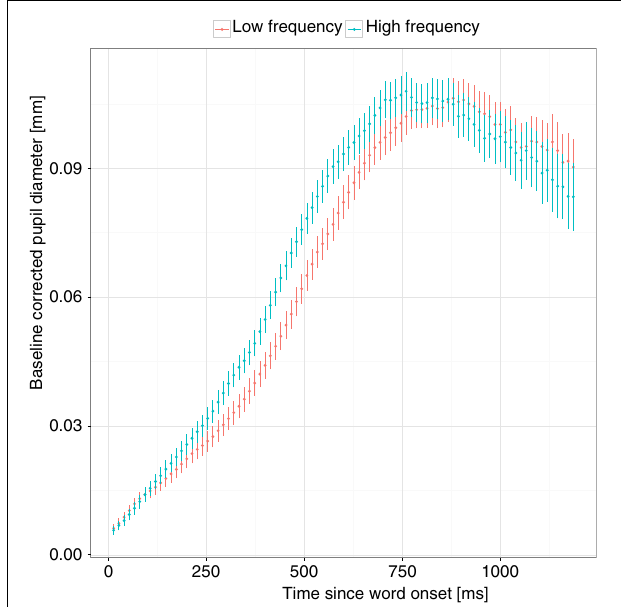
FIGURE 8 | The frequency effect for monolingual participants. The x-axis shows the time in milliseconds since word onset and the y-axis the baseline corrected pupil diameter. To illustrate the effect, words were divided into high and low frequency words based on a median split. Vertical lines around means show the standard error for each